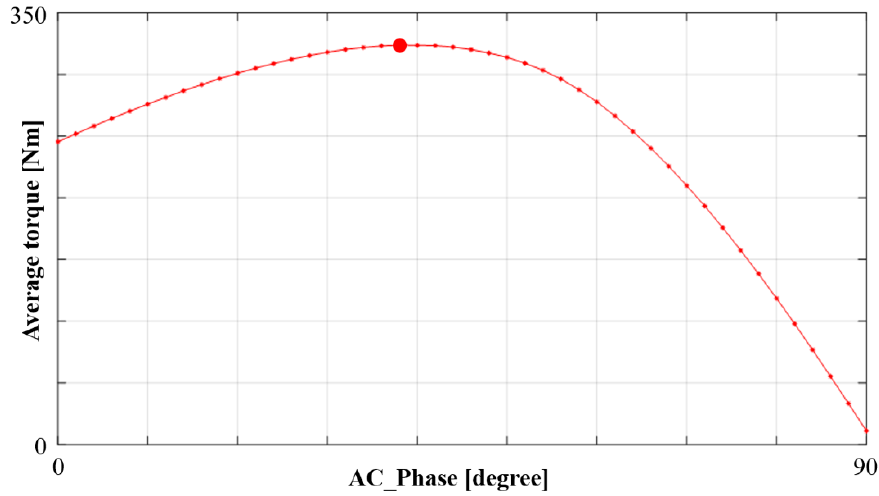
Figure 8. Comparison of average torque of the initial model according to the current phase angle.